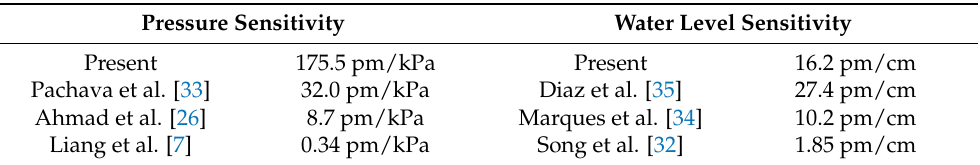
Table 4. Comparisons of the pressure and water level sensitivities between the present and other FBG sensors reported in the